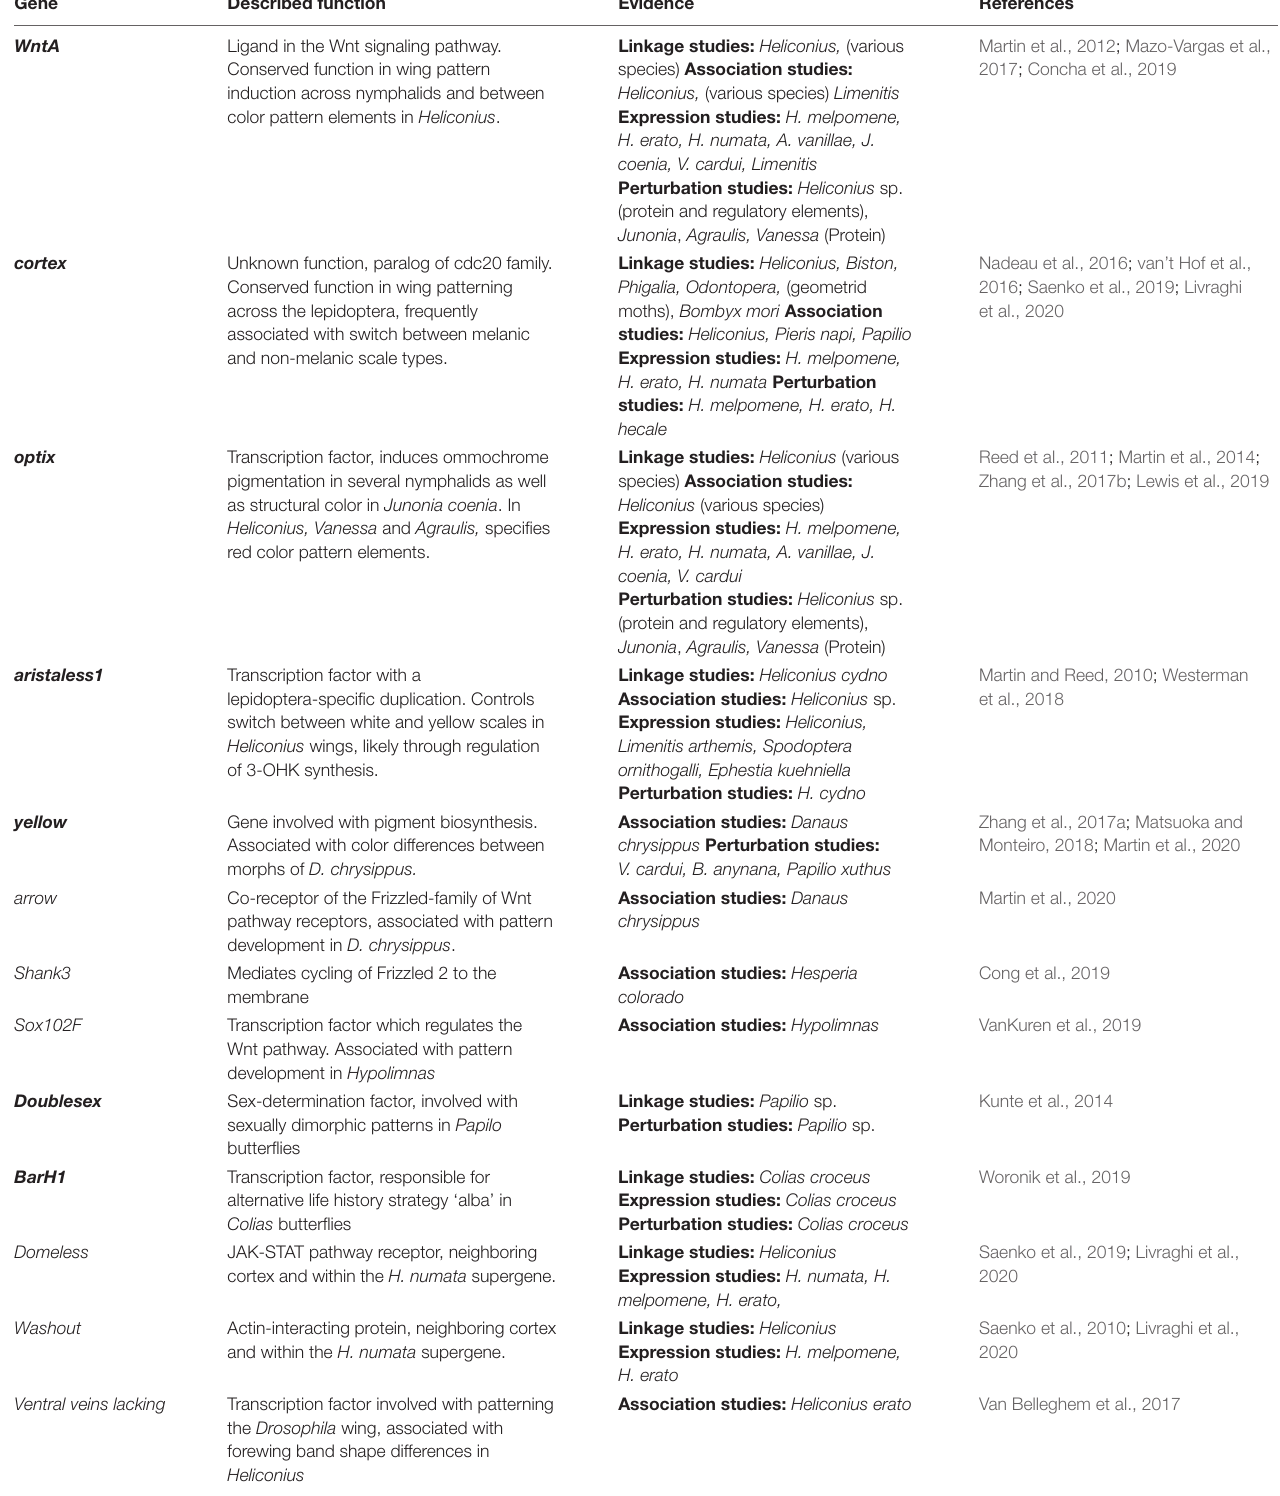
TABLE 1 | Wing genes that have been identified by linkage or association as involved with development of wing color or pattern in butterflies and moths. Gene Described